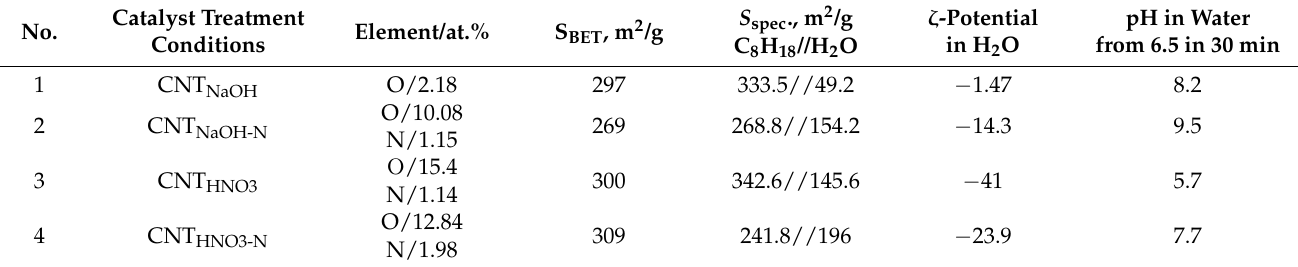
Table 1. Structural characteristics of surface and pH of studied CNT.